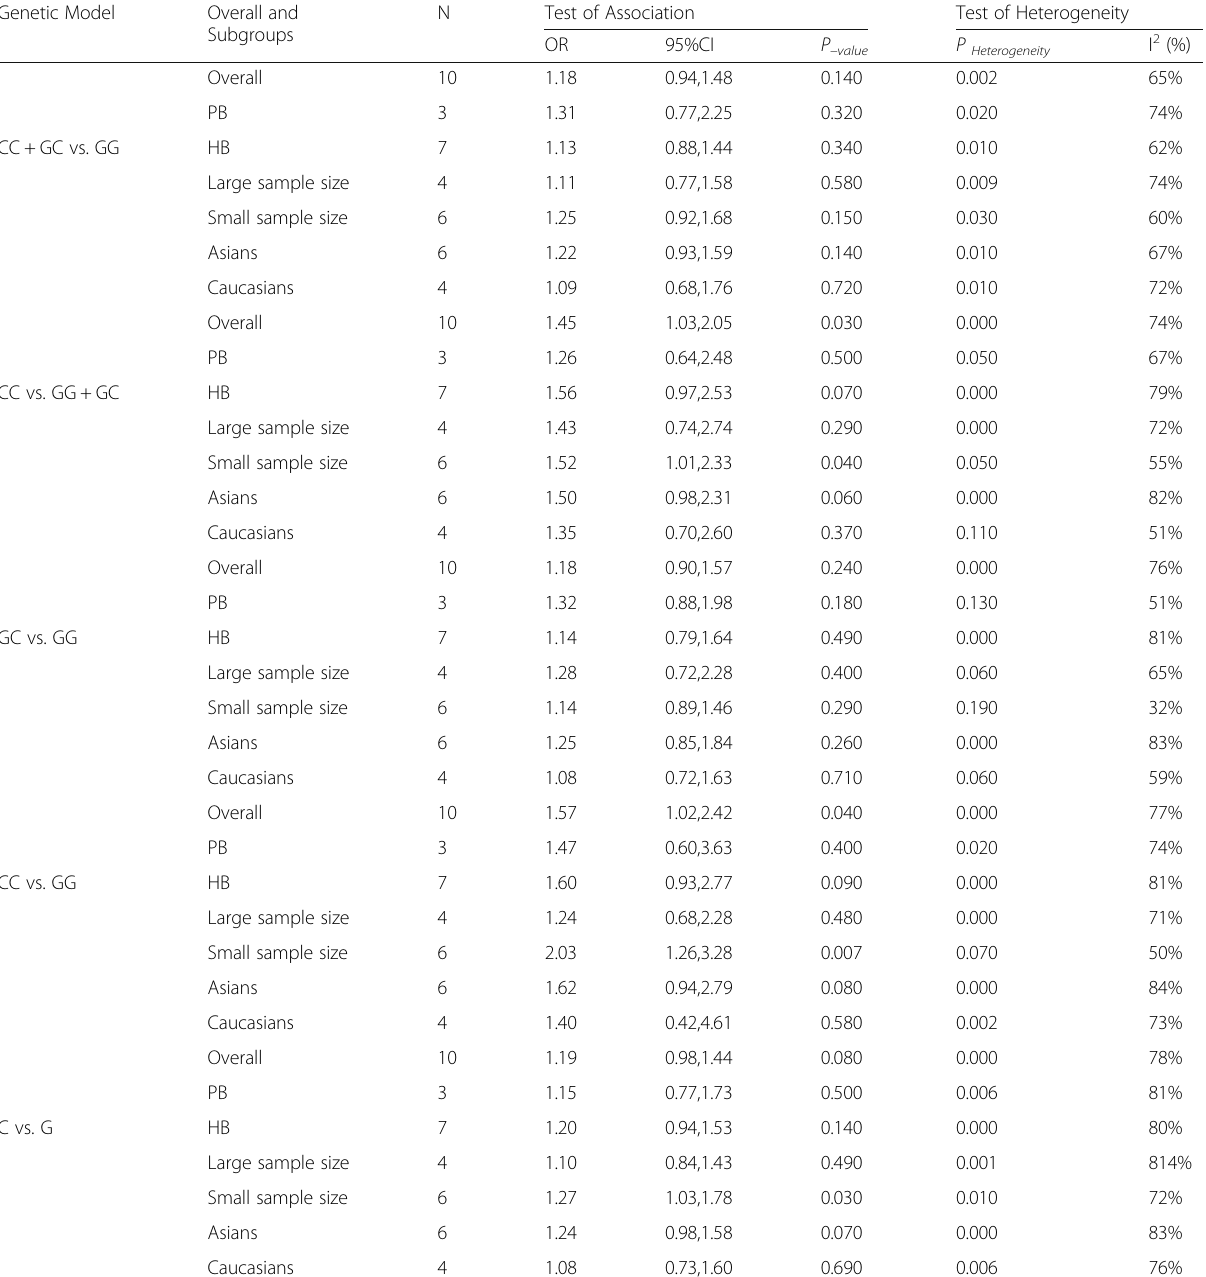
Table 3 Summary of odds ratios (95% CI) in the analysis of the relationship between VEGF gene polymorphisms in rs2010963 and coronary artery disease susceptibility Genetic